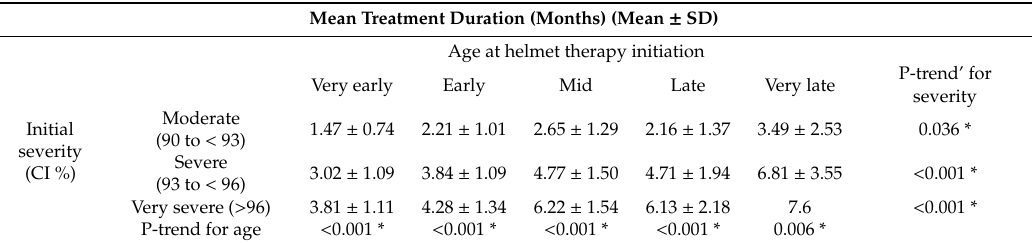
Table 5. Therapy duration according to the age and severity (Jonckheere–Terpstra